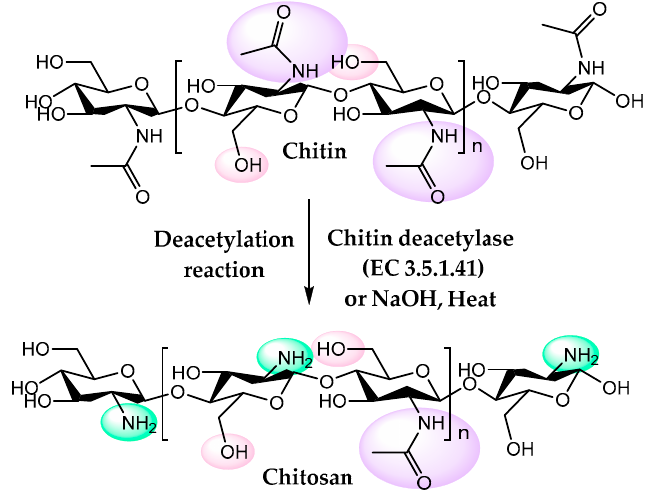
Figure 5. Chemical structure of chitosan. Chitin can be deacetylated by chitin deacetylases or by treatment in hot alkaline media. The backbone of chitosan is a linear homopolymer of β -(1,4)-2-amino- 2-deoxy- D -glucose. The highlighted groups (aqua = amino, light pink = hydroxyl and mauve = N - acetyl) represent the sites that can be chemically